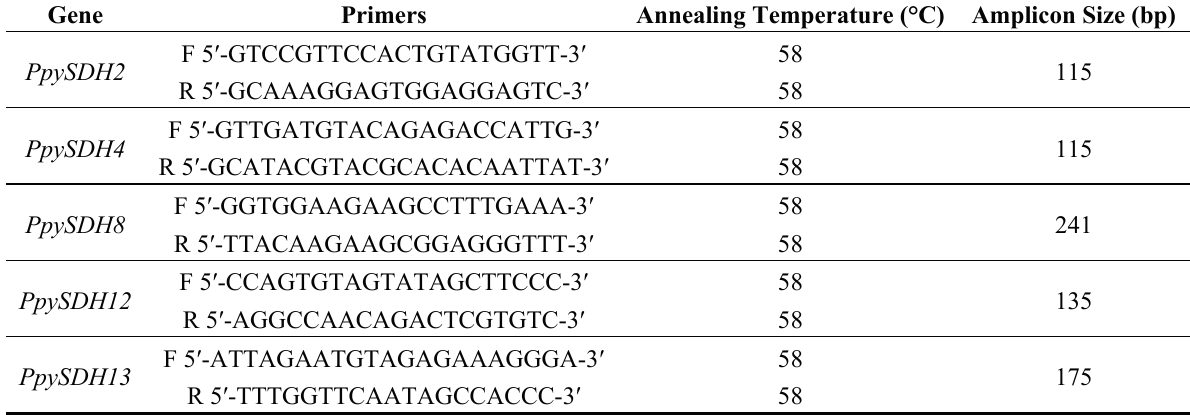
Table 5. Real-time PCR primers, annealing temperatures and expected amplicon sizes of six selected PpySDH